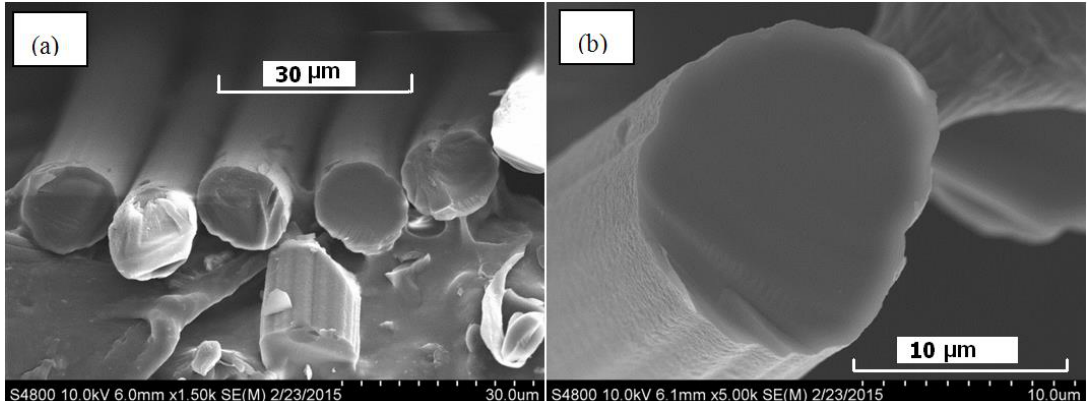
Figure 7. SEM micrographs of stretched as-spun Ace-SKL fibers at ( a ) low and ( b ) high magnification levels.